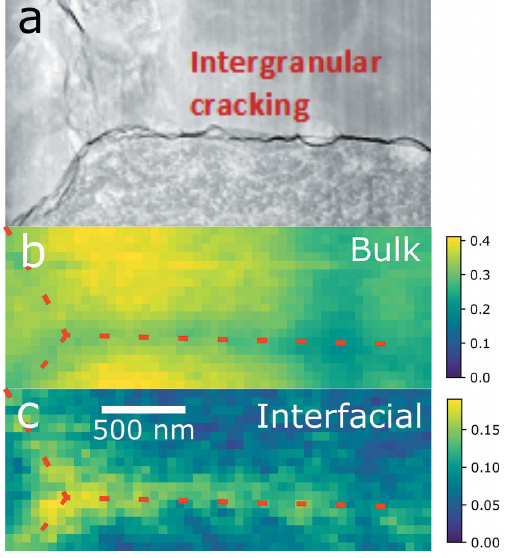
Figure 7 A comparison of ( a ) a high-angle annular dark-field (HAADF) scanning transmission electron microscopy (STEM) image with ( b ) bulk and ( c ) interfacial species maps of sample 1A, taken from the rim of the pellet. Each pixel of the stack was fitted as a linear combination of the NMF component spectra. Red lines on the species maps are a guide for the eye to indicate the position of the intergranular crack. Note the difference in the maxima of the intensity scale bars on the right-hand side. The STXM pixel size is 50 nm (cid:3) 50 nm and the HAADF-STEM image is scaled to match the STXM